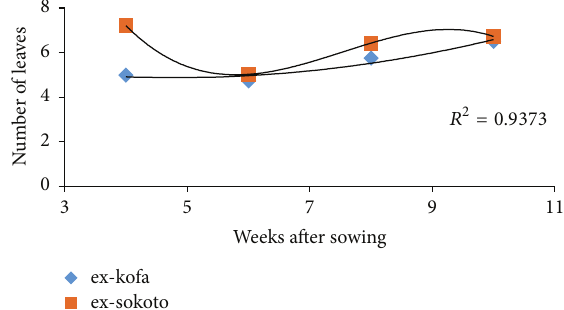
Figure 2: Significant ( 𝑝 < 0.05 ) growth trend of garlic varieties at 4, 6, 8, and 10 weeks after sowing on number of leaves. 𝑅 2 is the goodness of